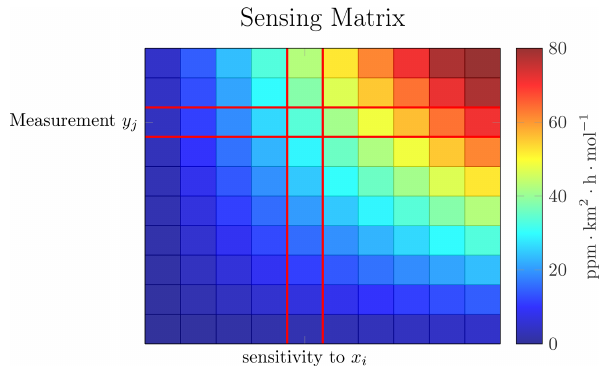
Figure 2. Visualization of a sensing matrix, where the values in the matrix are color encoded. The entry A ji in the matrix gives the sensitivity of the j th measurement to the i th grid cell.